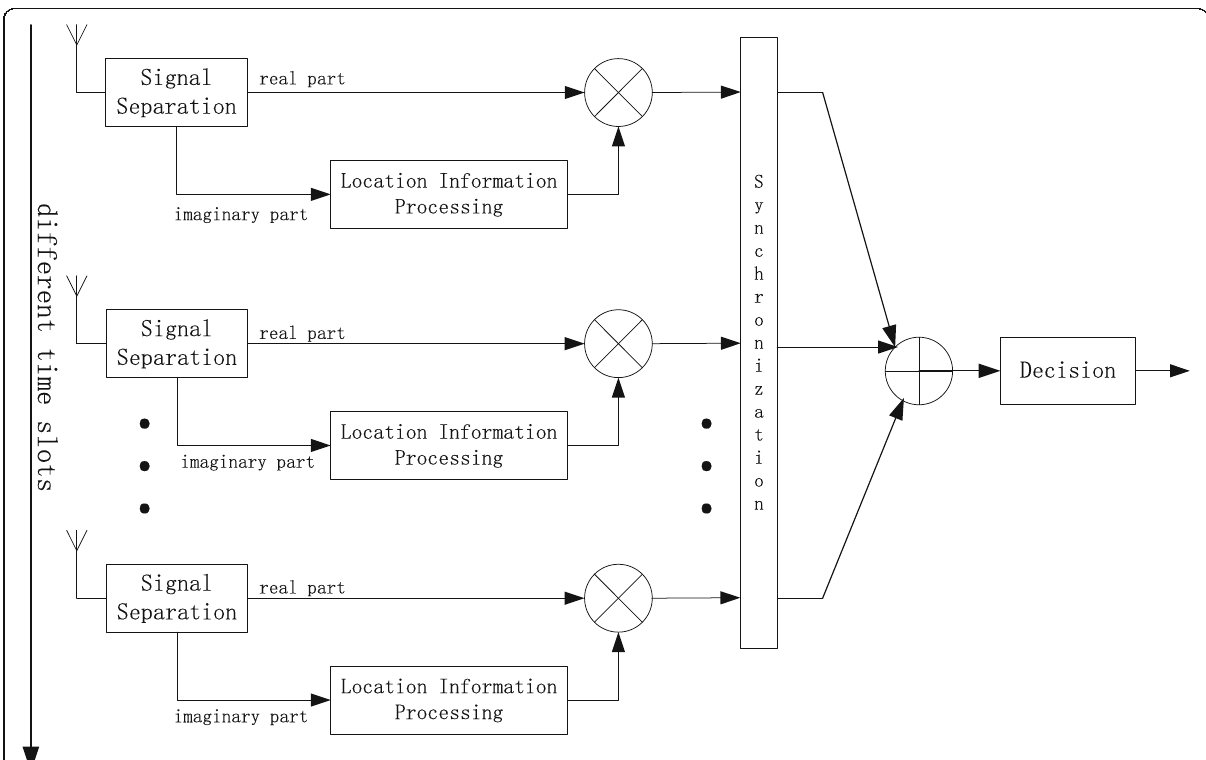
Fig. 4 Block combining at destination. The figure shows the detailed combining method at destination. The destination received several copies of signal in the different time slots. After decoding the signal, the imaginary parts of the signal are used to locate the information block and the real parts are synchronized. The information sequence blocks are combined as one information sequence according to their